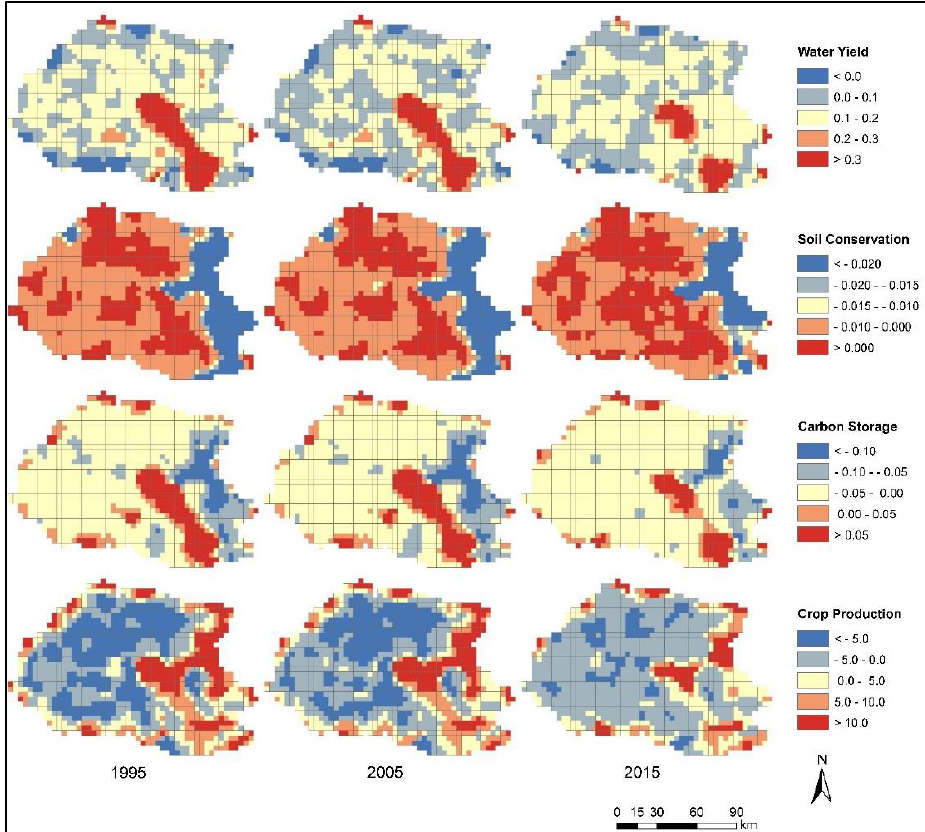
Figure 5. Spatial distributions of correlation coefficients between percentage of landscape (PLAND) and ecosystem services.